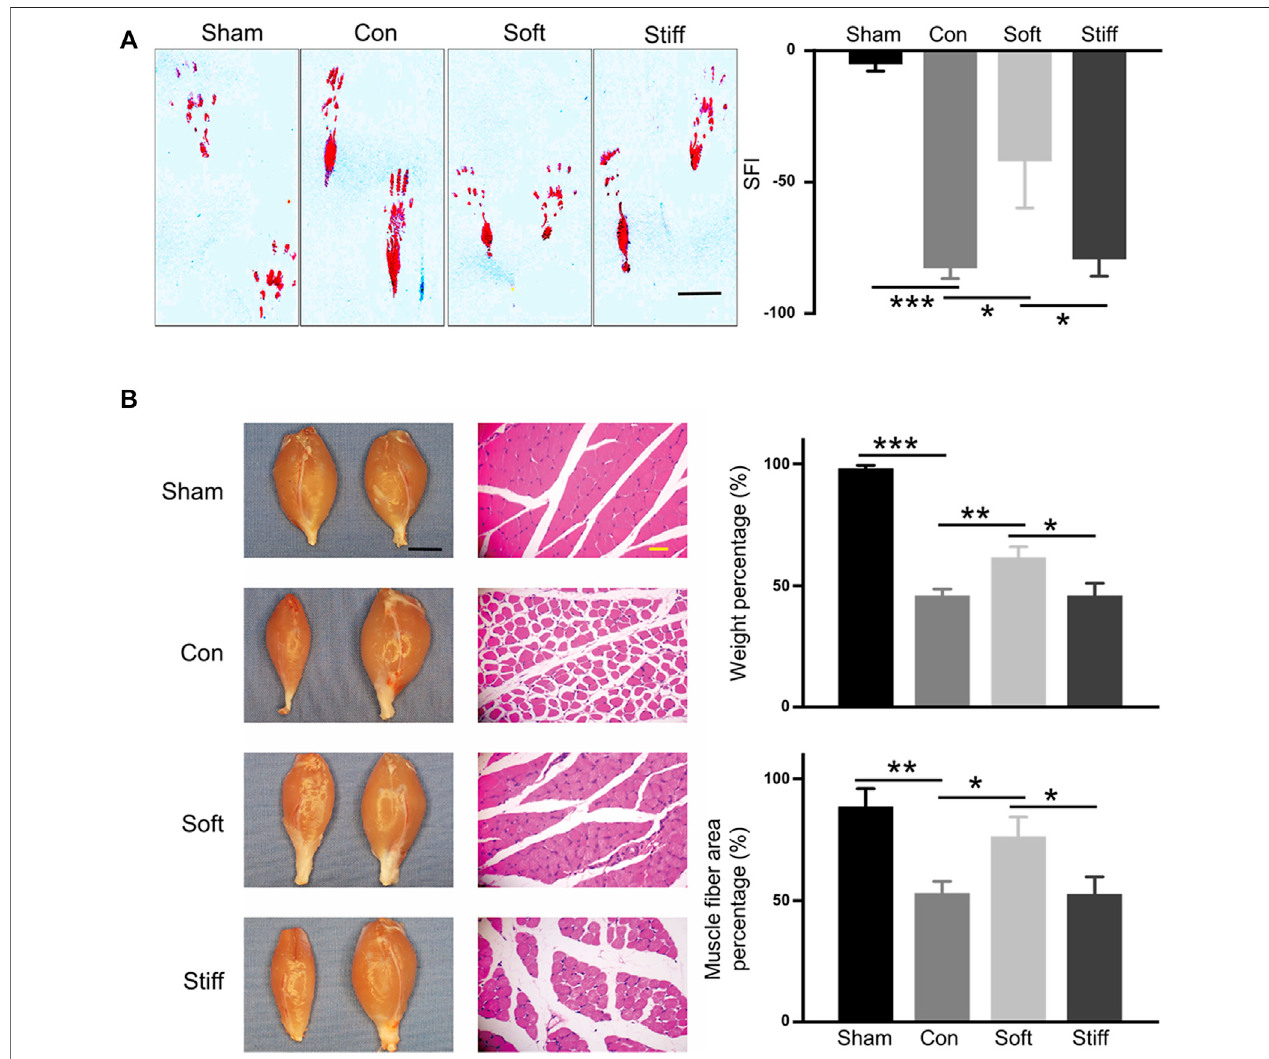
FIGURE2| Soft hydrogel – loadedexosomes canbetterrepairinjurednerves. (A) Rat hindfootprintswerecollectedafter surgery,and theSFIwasusedtoevaluate thefunctionalrecoveryoftheinjuredsciaticnerve(left:typicalfootprintpattern,7 days,bar=1 cm;right:SFIscore,14 days).Con:surgerygroup,sham:shamoperation group,convs.sham p =1.71649E-4;soft:softhydrogeltreatmentgroup,softvs.con p =0.01813);andstiff:stiffhydrogeltreatmentgroup,softvs.stiff p =0.02697. (B) Wet weight of the gastrocnemius muscle and the cross-sectional area of the gastrocnemius muscle fi bers. (left: photographs of rat gastrocnemius muscles on the operative and nonoperative sides and HE-stained images of the transverse section of the gastrocnemius muscle on the operating side, bar = 1 cm black, bar = 100 μ m yellow).